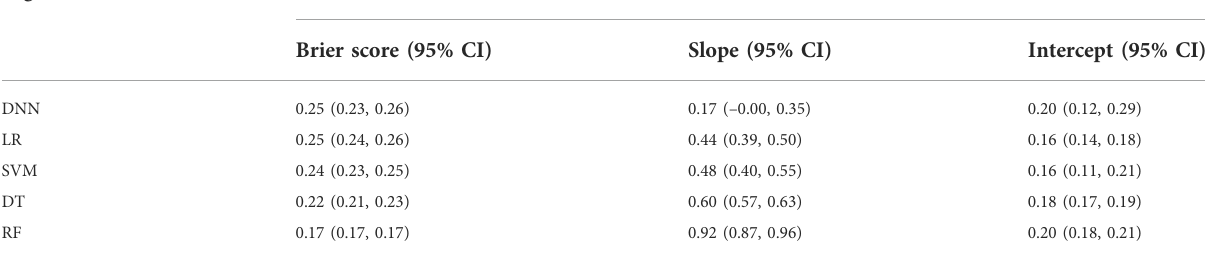
TABLE 3 Calibration tests of fi ve machine learning models for predicting preeclampsia. Algorithm